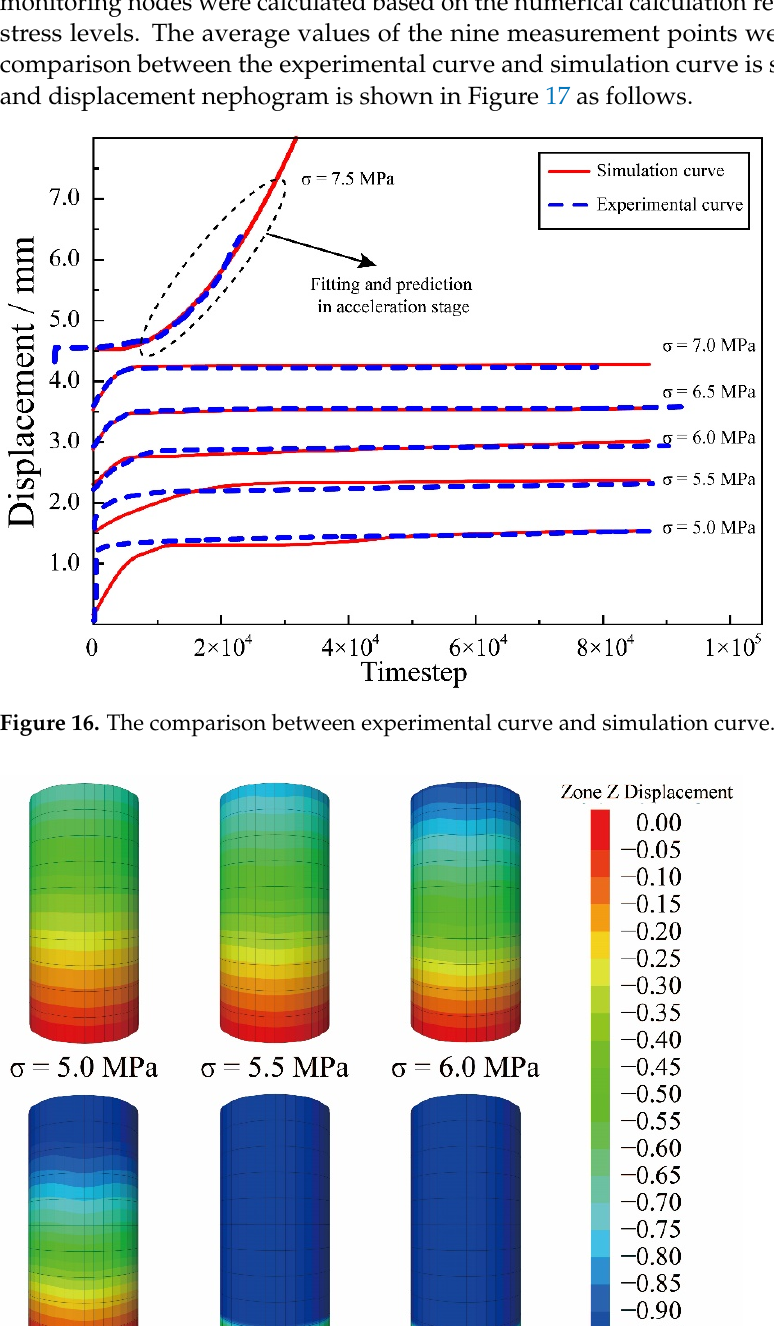
Figure 15. Model and distribution map of monitoring points.